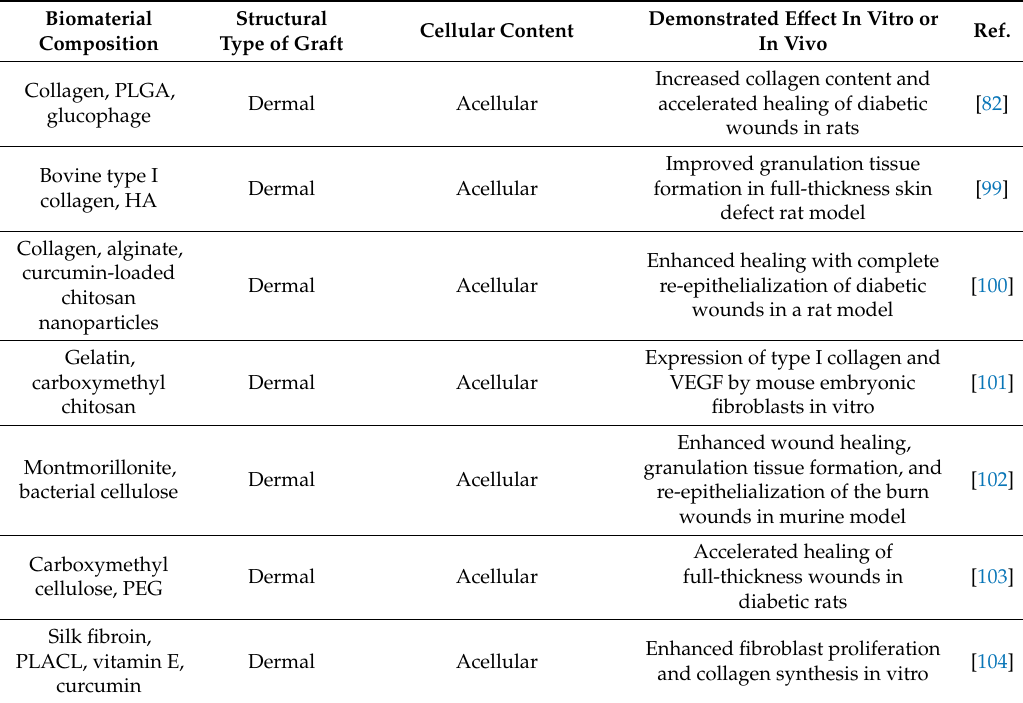
Table 1. Bioengineered artificial skin grafts made of various natural and synthetic polymers. Biomaterial